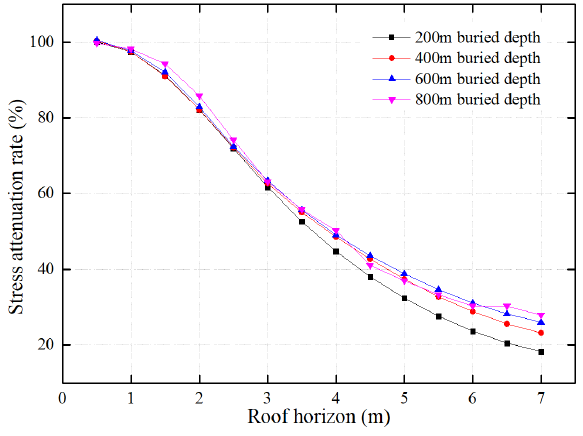
Figure 6. Stress attenuation rate of rock masses at different horizons of the roadway roof.